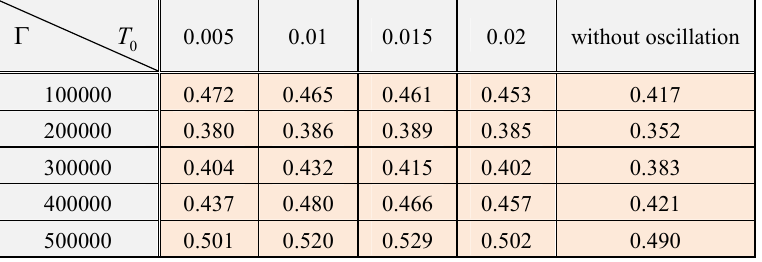
Fig.4 Instantaneous contours of the cell concentration